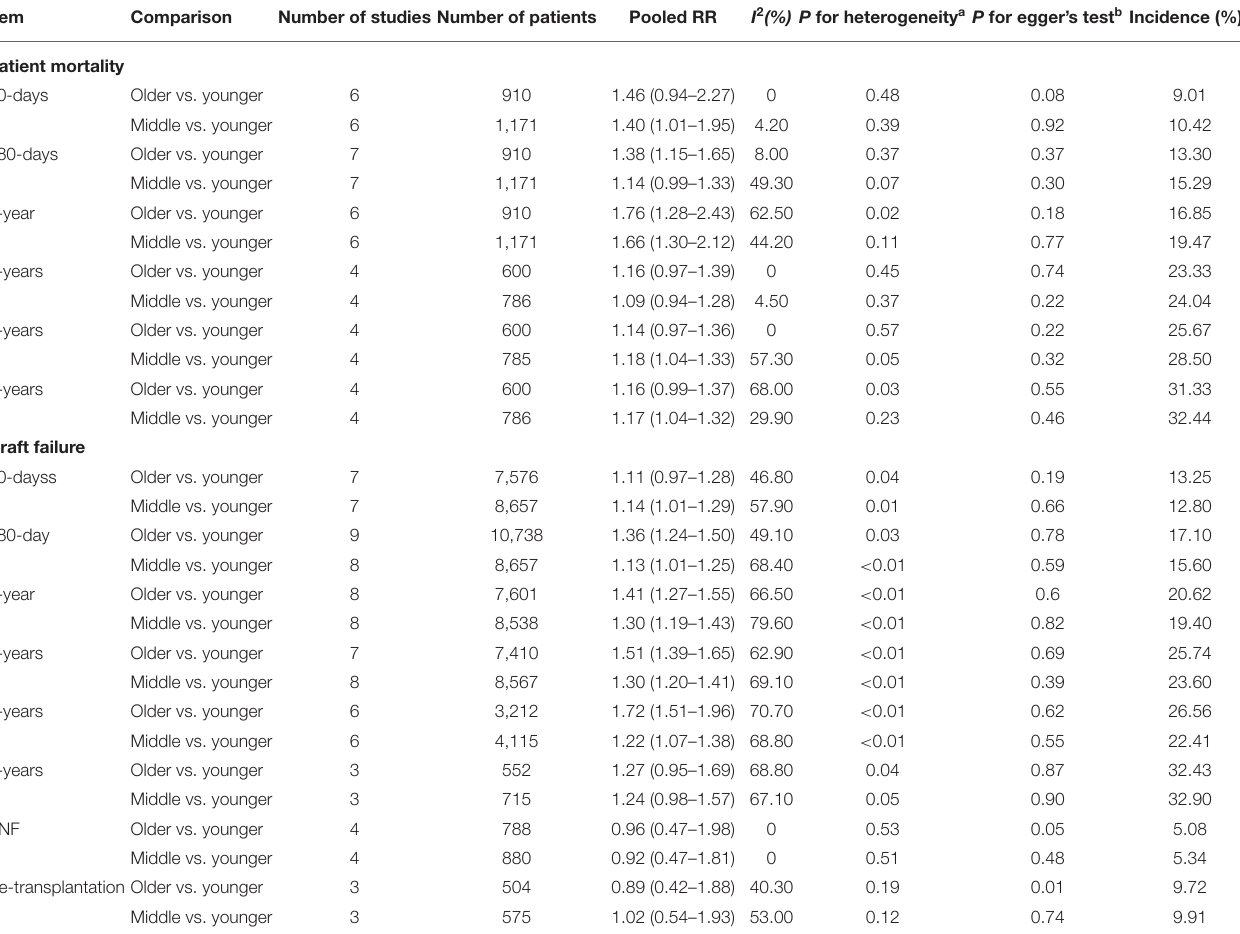
TABLE 1 | Comparison on post-operational outcomes categorized by donor